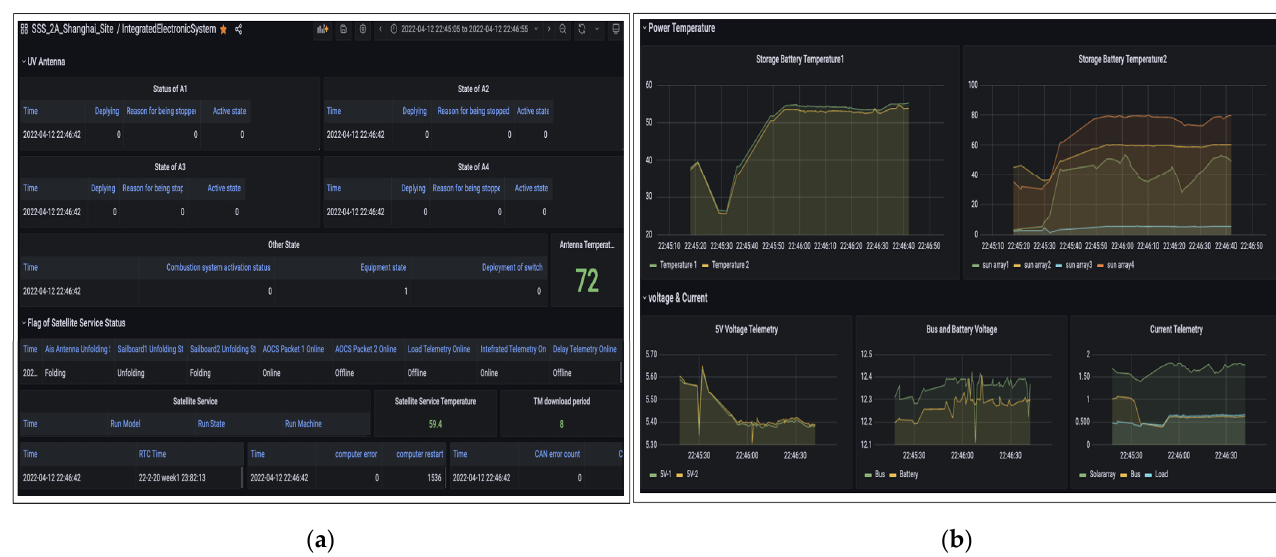
Figure 21. ( a ) SSS-2A integrated electronic system date; ( b ) SSS-2A power system